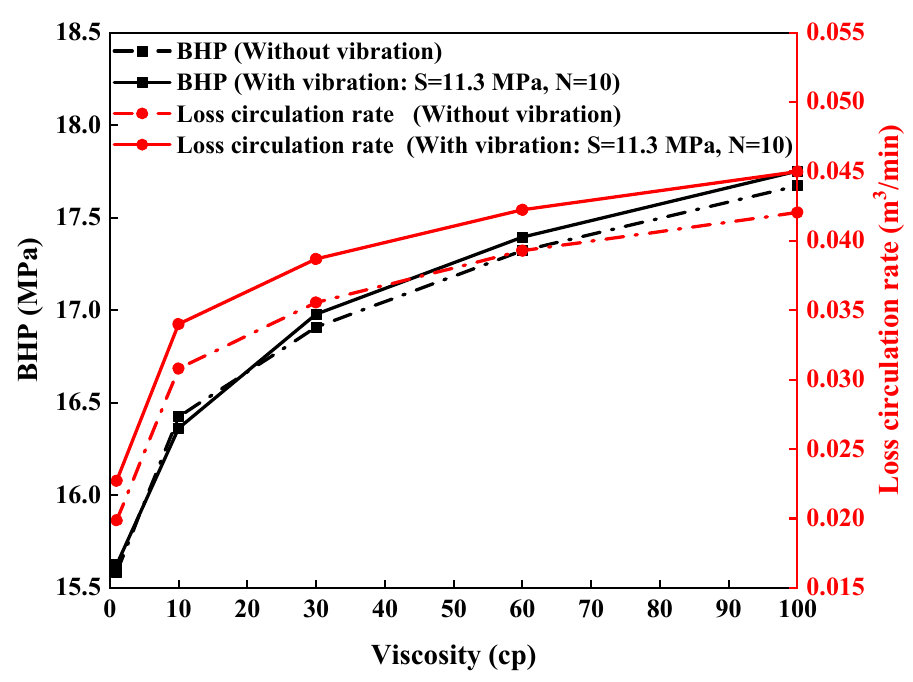
Figure 15. Effect of mud viscosity on loss circulation rate and BHP with and without vibration cyclic loads.